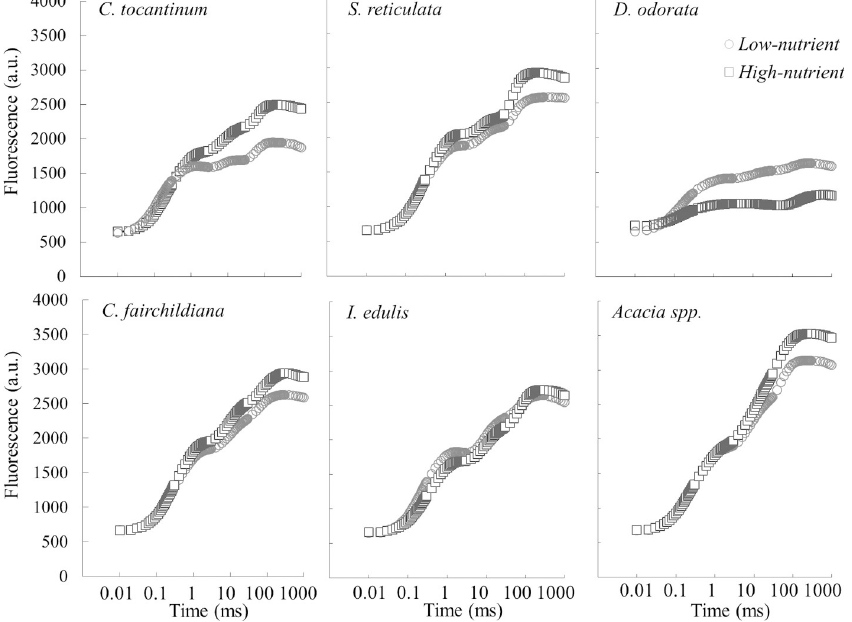
Fig 5. The OJIP transient curve for the six studied species of high- and low-nutrient plants.